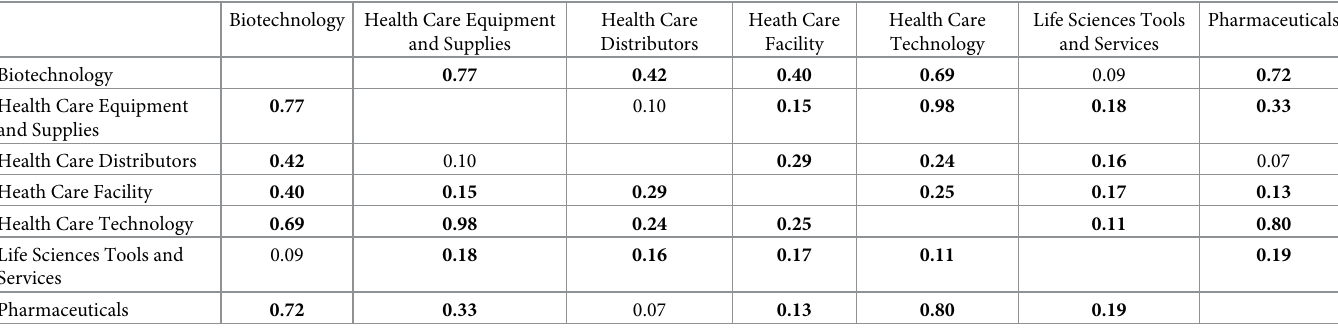
Table 8. Health care